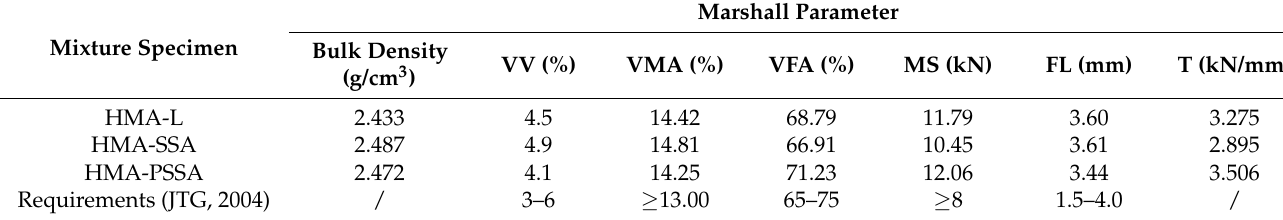
Table 9. Marshall test